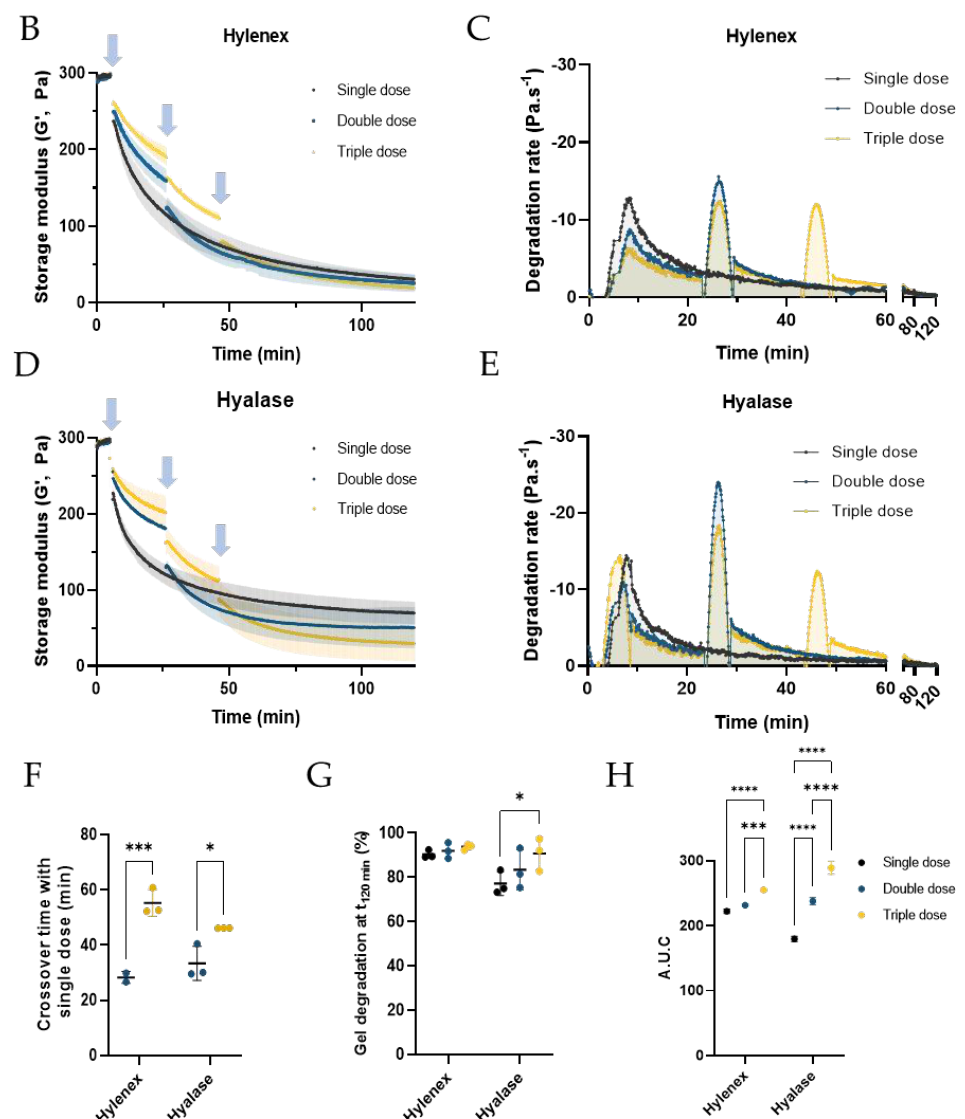
Figure 2. Evaluation of PNT4 degradation by single or multidose injections of Hylenex or Hyalase enzymes, followed by rheological time sweeps. ( A ) Schematic of the method used to degrade the PNT4 gels by single or multidose enzyme injections, ( B ) Evolution of the storage modulus of PNT4 gels over time, measured by time sweeps (37 ◦ C, strain 0.1%, 1 Hz) after single, double, or triple injections of the Hylenex enzyme. For all conditions, the total volume of enzyme added is 90 µ L, for a total enzymatic concentration of 34.6 U · mL − 1 ; blue arrows indicate enzyme addition, ( C ) First derivative curves of single, double, and triple dose injections, ( D ) Evolution of the storage modulus of PNT4 gels over time, measured by time sweeps (37 ◦ C, strain 0.1%, 1 Hz) after single, double, or triple injections of the Hyalase enzyme. For all conditions, the total volume of enzyme added is 60 µ L, for a total number of 277.8 U · mL − 1 ; blue arrows indicate enzyme addition, ( E ) First derivative curves of single, double, and triple dose injections; blue arrows indicate enzyme injections with the Hyalase enzyme, ( F ) Crossover time at which multidose storage moduli are lower than with a single dose, ( G ) Storage moduli at plateau obtained after single, double, or triple addition of enzyme, ( H ) area under the curve (AUC) extracted from the degradation rates of PNT4 gels using both enzymes. All results are presented as mean ± S.D, n =